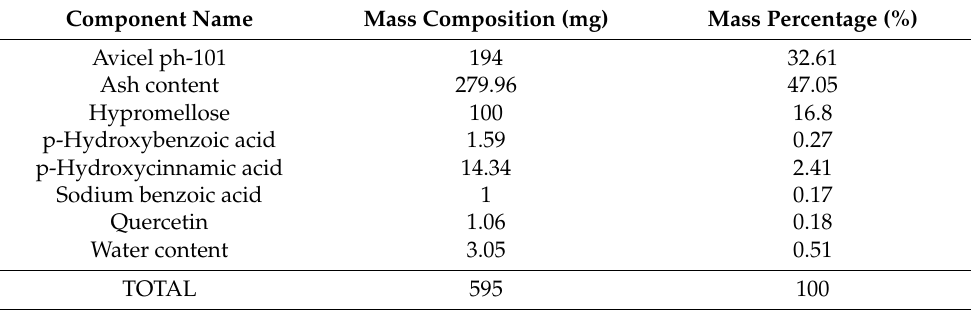
Table 2. Longevity spinach extract capsule components.